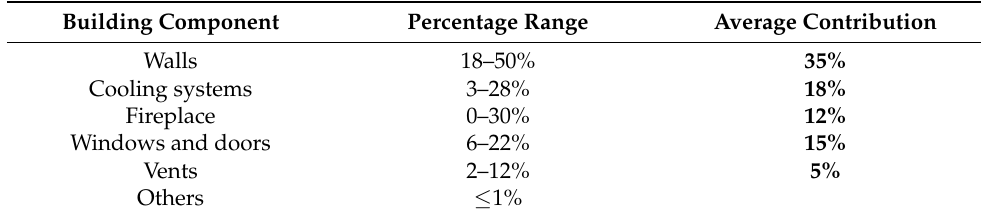
Table 1. Envelope component contribution to air infiltration in residential buildings